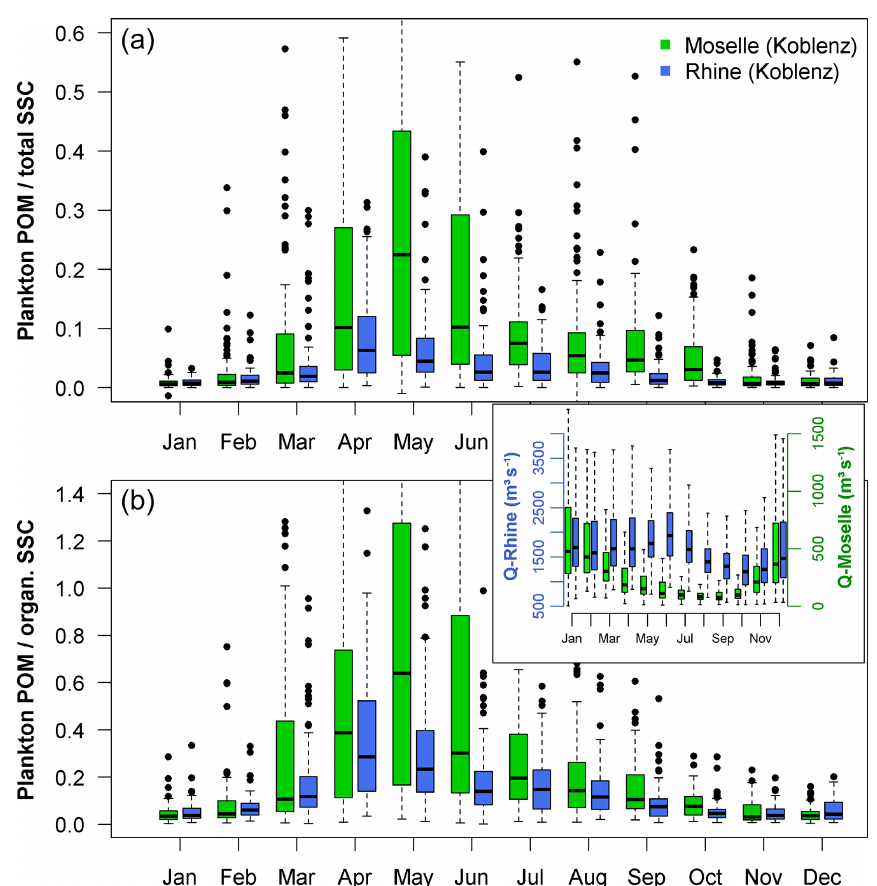
Figure 9. Box plot of the seasonal variation of plankton POM with respect to total SSC (a) and organic SSC (b) for the stations Koblenz Rhine (blue) and Koblenz Moselle (green) from 1990 to 2017. Organic SSC is derived from LOI measurements, and plankton POM is calculated from Chl a measurements using a POC / Chl a ratio of 40 and a POC / POM ratio of 0.42. Plankton POM / organic SSC ratios > 1 are due to measurement errors of Chl a , and those for LOI are due to simplified conversion ratios. The inset shows the box plot of seasonal discharge variations at both